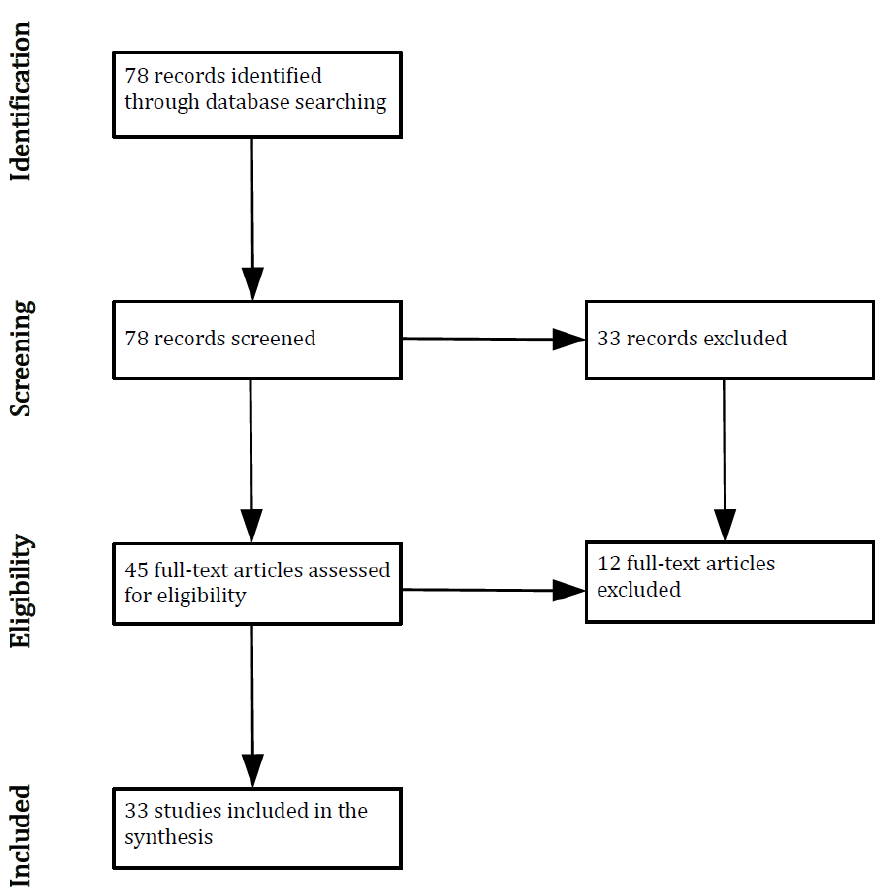
Figure 1. PRISMA selection diagram that explains the main steps of our survey methodology (see text for